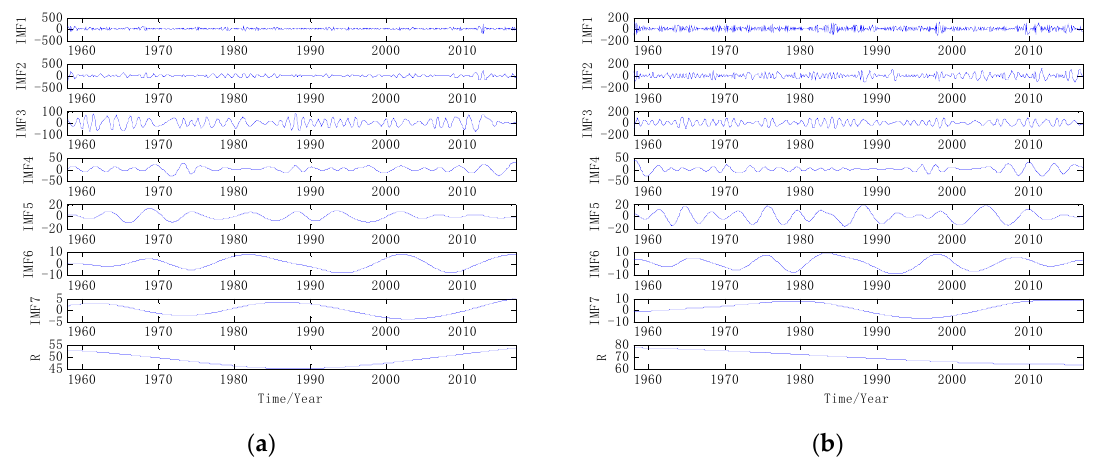
Figure 4. The results of VMD method ( a ) Yan’an; ( b ) Huashan.